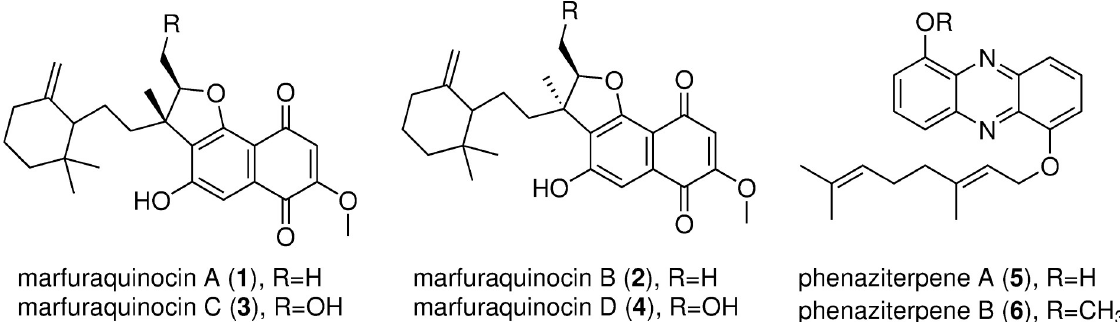
Fig 1. The chemical structure of compounds marfuraquinocins A-D (1–4) and phenaziterpenes A-B